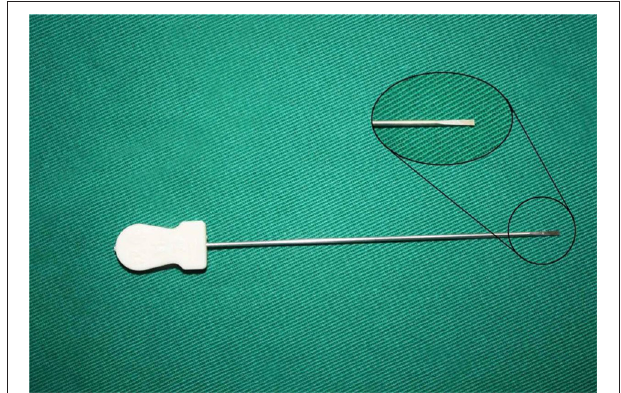
FIGURE 2 | The scheme of Hanzhang needle knife. The needle knife consists of three parts: tip, body and handle, with a 0.8mm blade on the tip, and 40mm length of the body. The tip can serve as a scalpel during